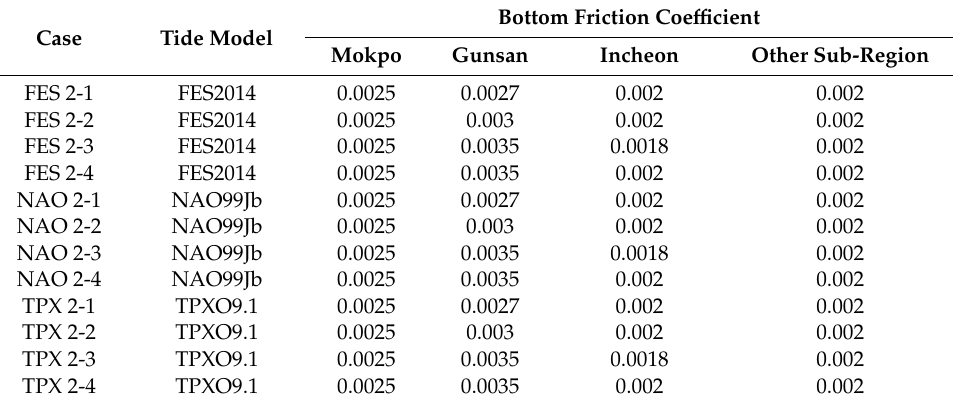
Table A5. List of simulation cases applying non-uniform bottom roughness coe ffi cients to di ff erent sub-regions of WCK.